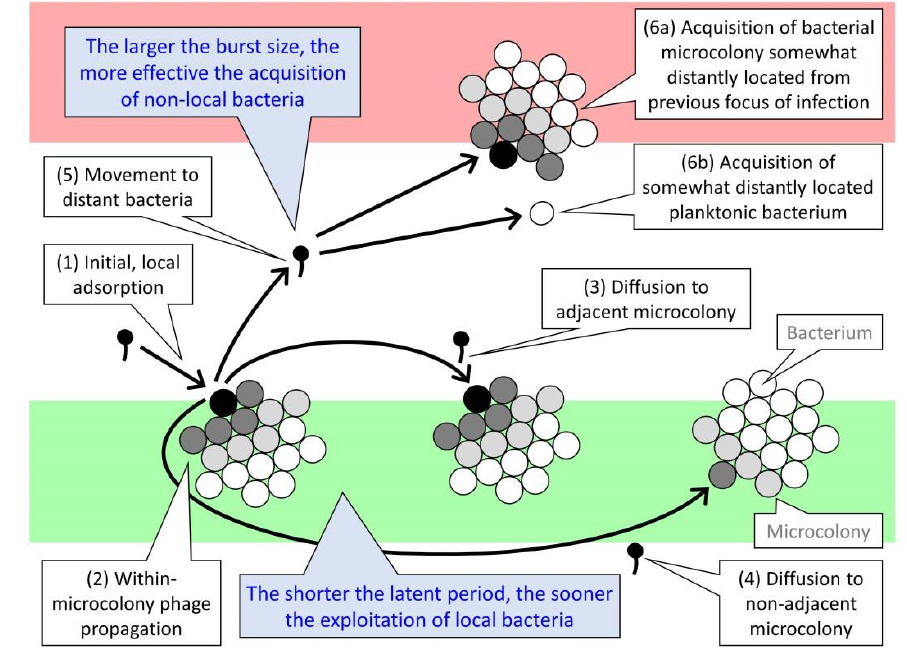
Figure 9. A model of the ecology of biofilm exploitation by bacteriophages, here as differentiated in terms of more localized versus more distant bacterial targets. The green-colored stripe along the bottom of the figure represents the focus biofilm, with a focus of phage infection as initiated, e.g., by a single phage virion particle ( 1 ). This focus of infection is associated with various bacterial microcolonies, in this case consisting of bacteria which are similarly susceptible to the phage in question. The red-colored stripe across the top represents a somewhat spatially distant biofilm, i.e., as could be centimeters or more separated from the lower biofilm. In this second biofilm, only a single associated microcolony is illustrated. The more virions produced in association with the lower biofilm—especially given virion dilution into the environment and inevitable virion decay over time—then the greater the likelihood that the upper biofilm will be discovered by phages released from the lower biofilm ( 6a ), or instead that planktonic bacteria will be encountered and then adsorbed ( 6b ). Notwithstanding that fewer virions would be produced, given shorter phage latent periods, then faster local exploration of biofilms should be possible (Section 6.1). This is illustrated within the lower biofilm ( 2 , 3 , and 4 ). In addition, with shorter phage latent periods, then the sooner that phage virions may leave this biofilm in search of new biofilms to exploit ( 5 ), albeit with fewer phages released per phage-infected bacterium. Lysis inhibition, by being an inducible latent-period extension, thereby could allow for both strategies: (i) shorter latent periods during local exploration for new bacteria to infect as well as sooner virion spread out of biofilms towards more distant bacteria, but also (ii) greater virion production towards increasing the potential to discover those more distant bacteria. See Section 4.1.4 for a description of an analogous scenario during wild-type phage T4 plaque growth. The figure is derived and modified from those found in Abedon [80,121,122].